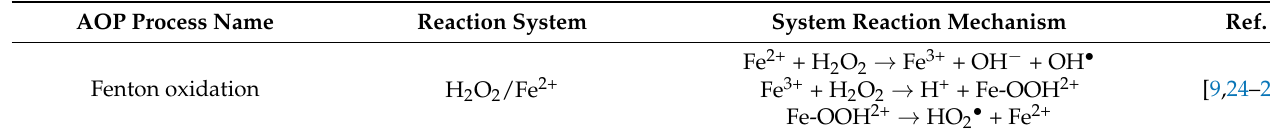
Table 1. Overview of AOP processes and their mechanisms of generating hydroxyl